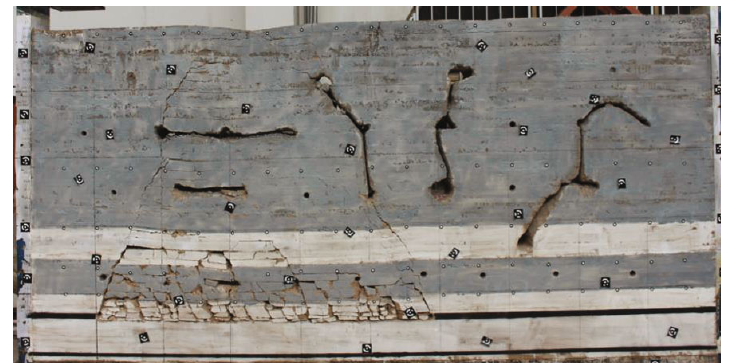
Figure 3: Water inrush passage in the overburden (mining distance is 290 m).